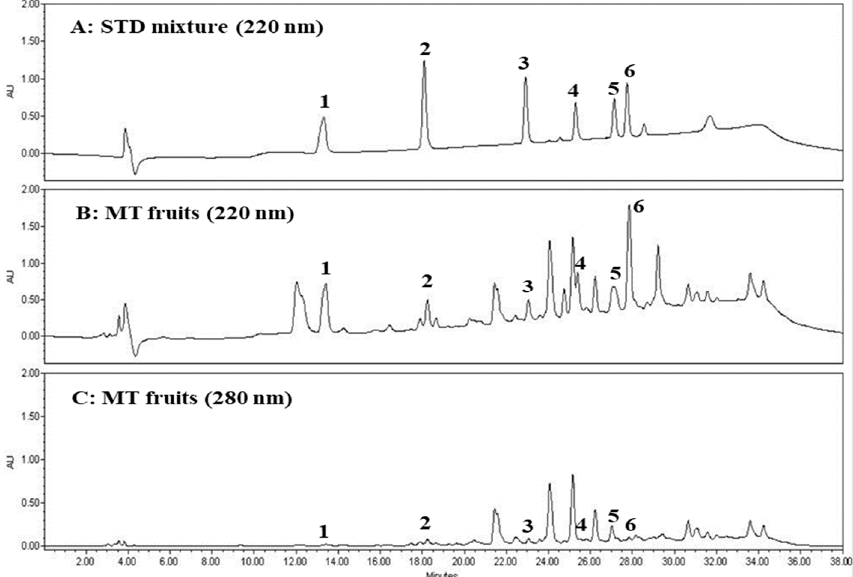
Figure 4. HPLC chromatograms of standard (STD) mixture of parishin derivatives ( A ) and 70% methanol extract of fully mature M. tricuspidata (MT) fruit at 220 nm ( B ) and 280 nm ( C ). 1, gastrodin; 2, 4-HBA; 3, parishin E; 4, parishin B; 5, parishin C; 6, parishin A.